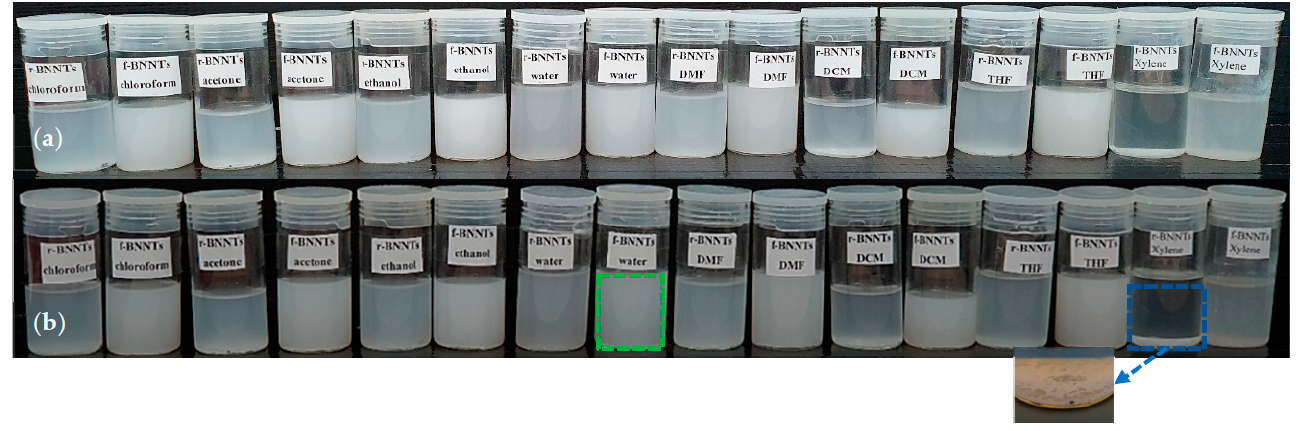
Figure 5. Dispersion of r-BNNTs and f-BNNTs in various solvents: ( a ) 12 h; ( b ) 48 h, inset: sedimen- tation in r-BNNTs after 48 h.